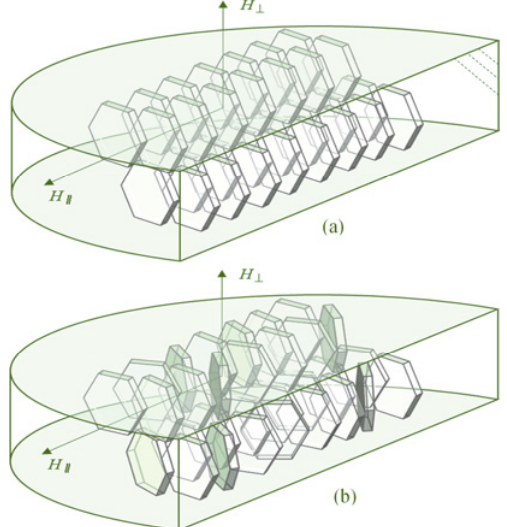
Fig. 5 (a) Ideal model and (b) real model of grain configuration in sintered oblate cylindrical SrM specimen.